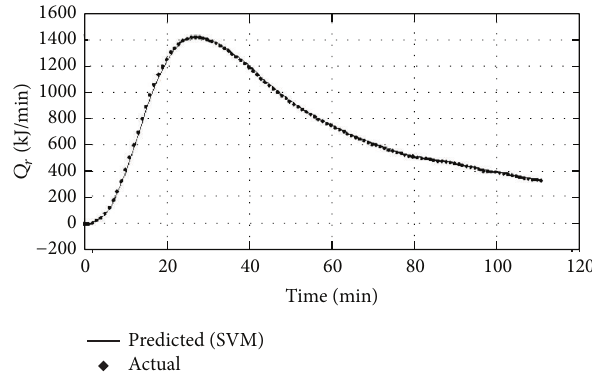
Figure 7: Response of SVM 𝑄 𝑟 estimator under normal